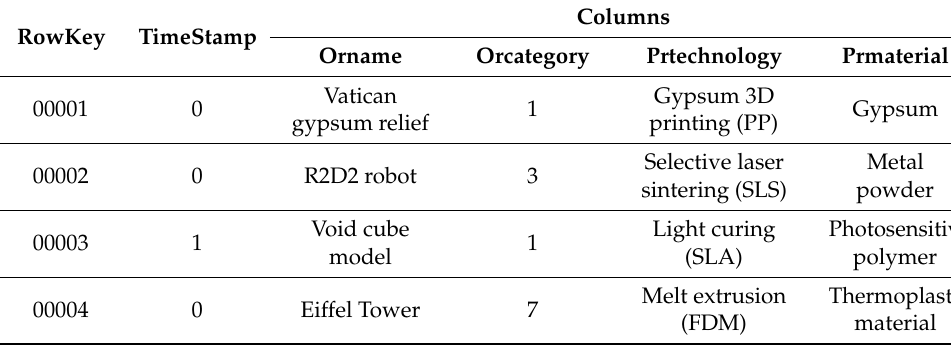
Table 3. The attribute table of C3DPS node